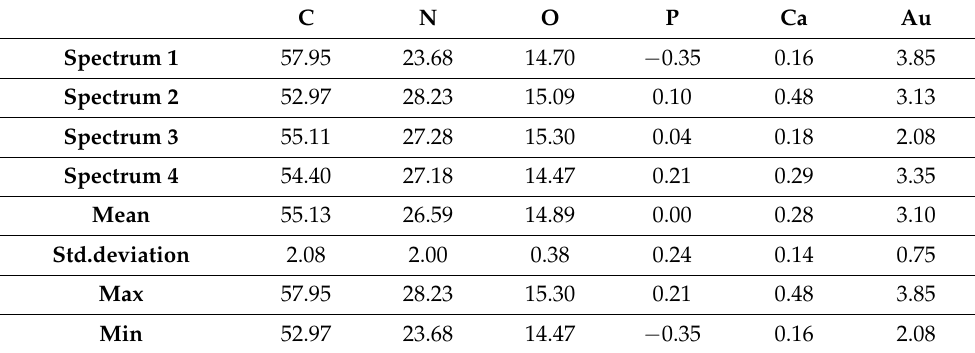
Figure 4. ( A ). An SEM image of the dentin graft exhibiting longitudinally sectioned tubules, ×2.7·10 3 . ( B ). Transversal section of dentin showing a tubule where the openings are devoid of cell processes, ×8.3·10 3 . ( C ). Close up of the tubules with regular peritubular walls and irregular inter-tubular den- tin, ×19.8·10 3 .